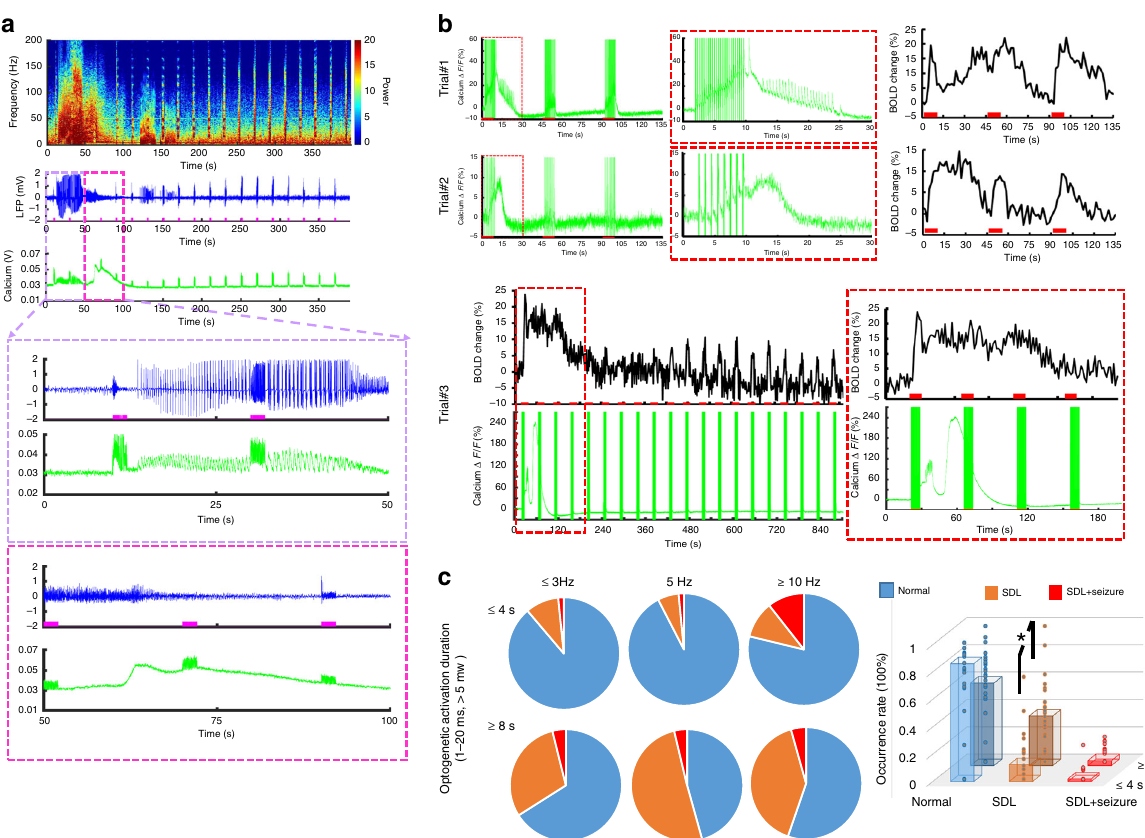
Fig. 4 SDL and seizure-based Ca 2 + recordings with LFP or fMRI. a Representative traces of SD and seizure spikes in the hippocampus: power spectra of LFP (top), LFP trace (middle), and Ca 2 + signal (bottom). Zoomed views of the area are outlined in the upper panel (purple/pink box) (illumination: 10 ms light pulse, 50 Hz, 2 s, 5.5 mW). b Representative trials (3 rats) of neuronal Ca 2 + signal (green) with simultaneous single-vessel BOLD fMRI signal (black) (upper: 10 ms light pulse, 1 Hz, SDL and 3 Hz, SDL + seizure Ca 2 + events, 8 s, 6 mW; lower: 20 ms light pulse, 5 Hz, 8 s, 5.5 mW). Zoomed views of the area are outlined in the red box. c Quanti fi cation of the occurrence percentage of normal, SDL and SDL + seizure Ca 2 + events as a function of optogenetic light pulse frequency ( ≤ 3 Hz, 5 Hz, ≥ 10 Hz) and stimulation duration (( ≤ 4 s, 382 trials, ≥ 8 Hz, 448 trials, n = 28 rats). Induction rate of SDL-Ca 2 + events in trials with 8 s stimulation duration is signi fi cantly higher than that of trials with 4 s stimulation (* p = 0.001, n = 28 rats, mean ± fMRI maps show slowly spreading BOLD signals from individual venules through the sub-centimeter scale hippocampal vascu- lature corresponding to SDL-Ca 2 + events, which are different from the optogenetic activation pattern speci fi c to evoked Ca 2 +